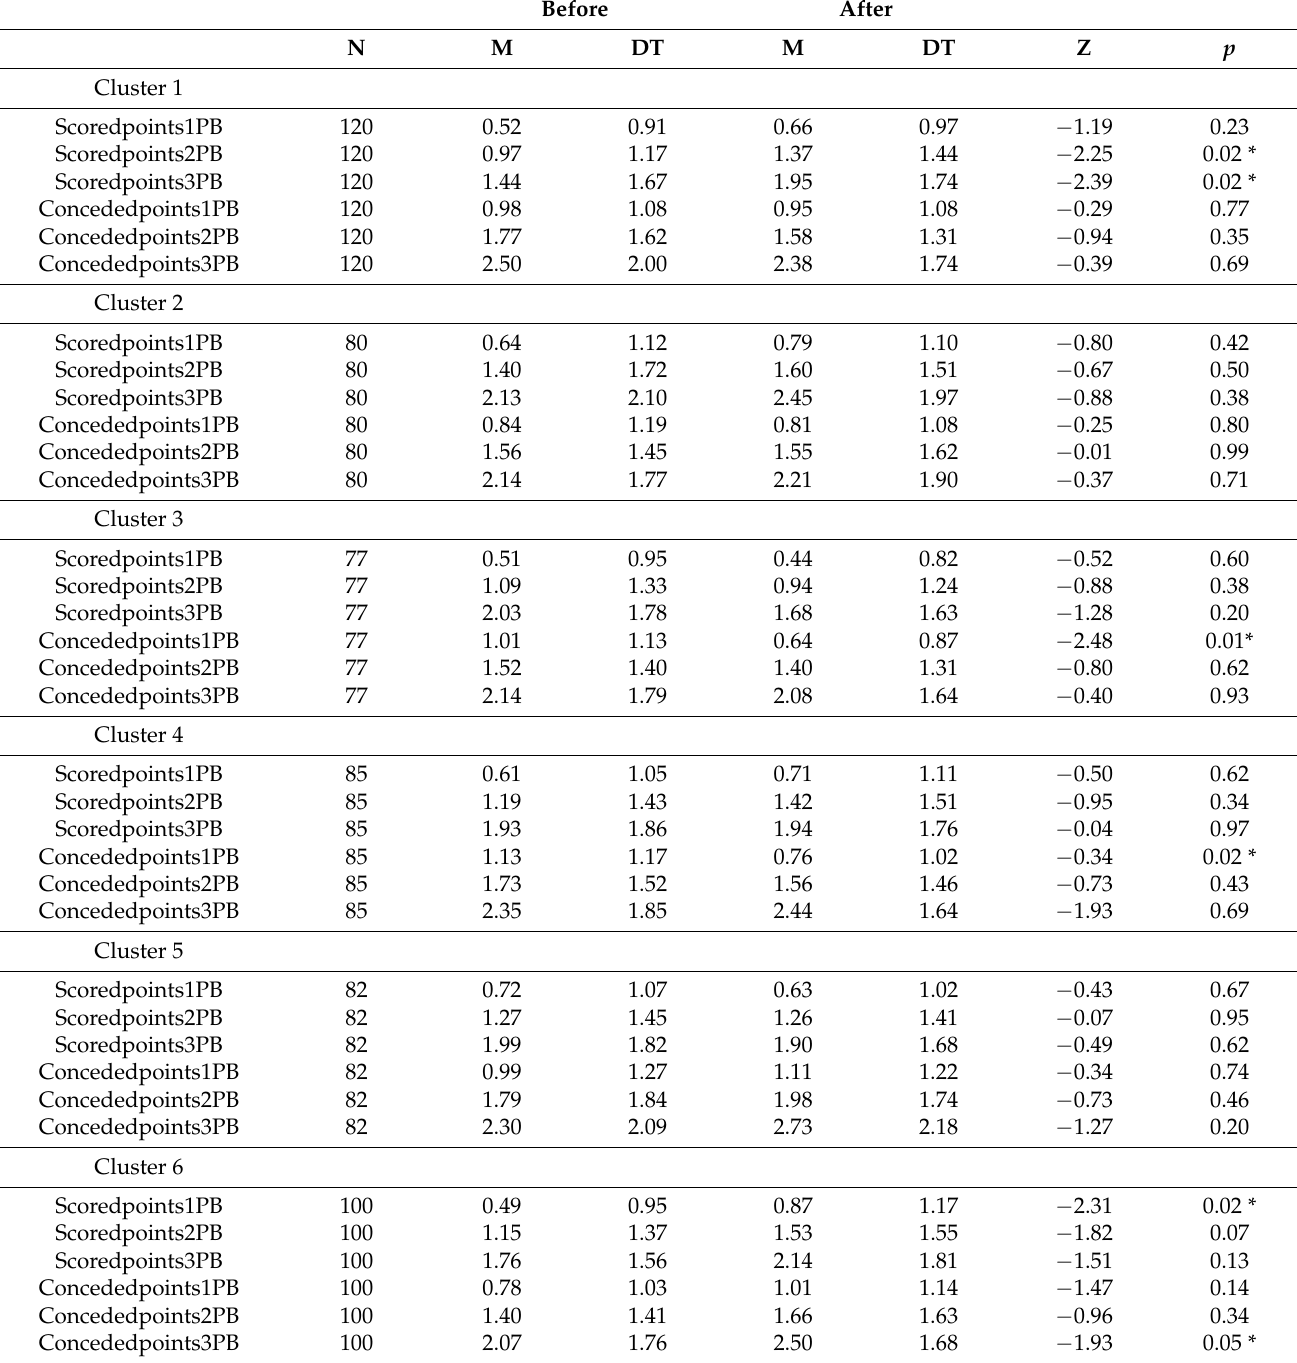
Table 2. Descriptive results of points scored and conceded for each cluster, and mean differences between performance before and after the episode of anger (Wilcoxon repeated-measures